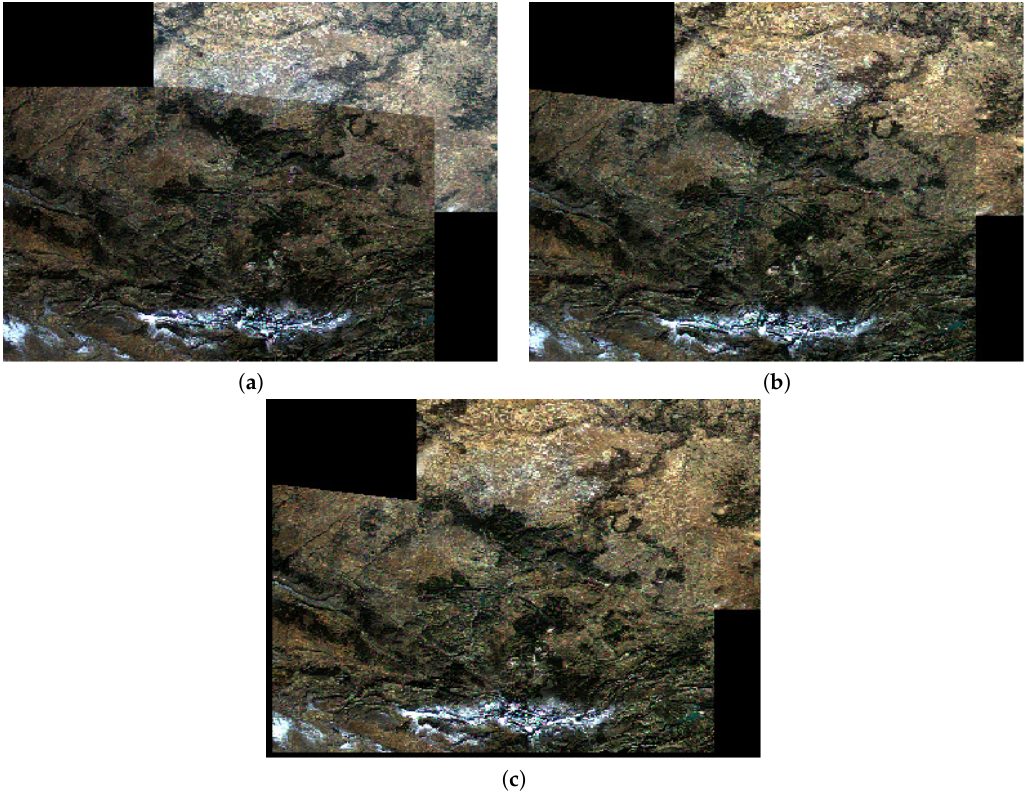
Figure 4. Atmospheric effects over the satellite image for the Rio Martin watershed. ( a ) Non-corrected image, ( b ) image with atmospheric correction, and ( c ) image with radiometric